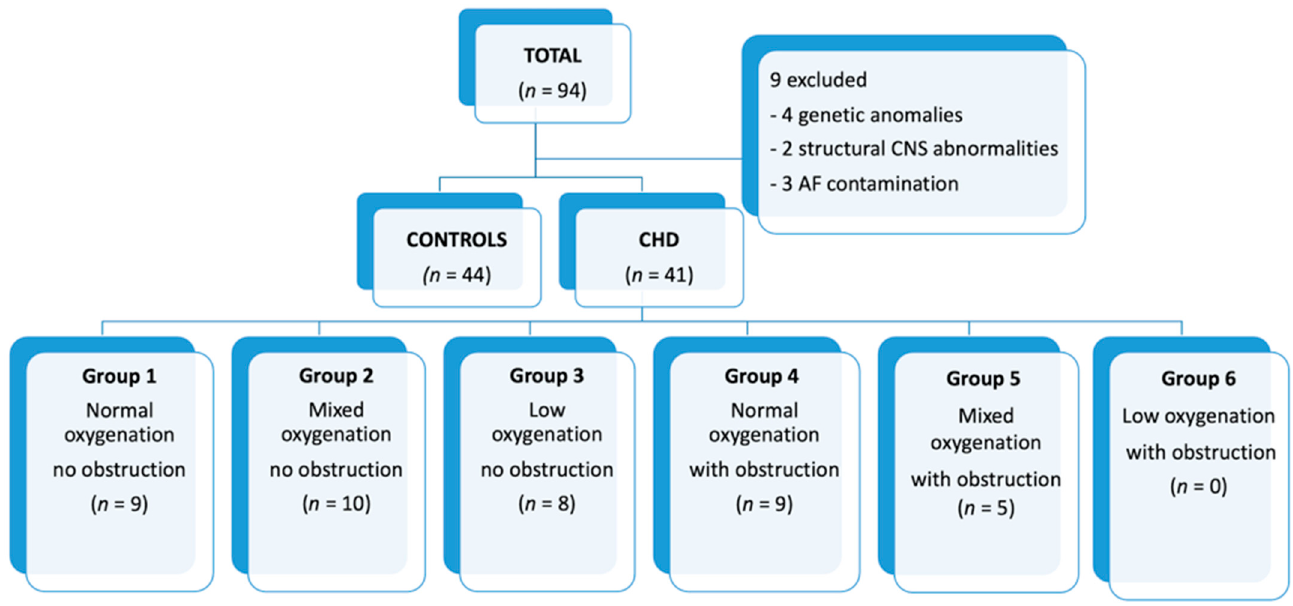
Figure 2. Distribution of patients. CHD: congenital heart disease; CNS: central nervous system; AF: amniotic fluid.